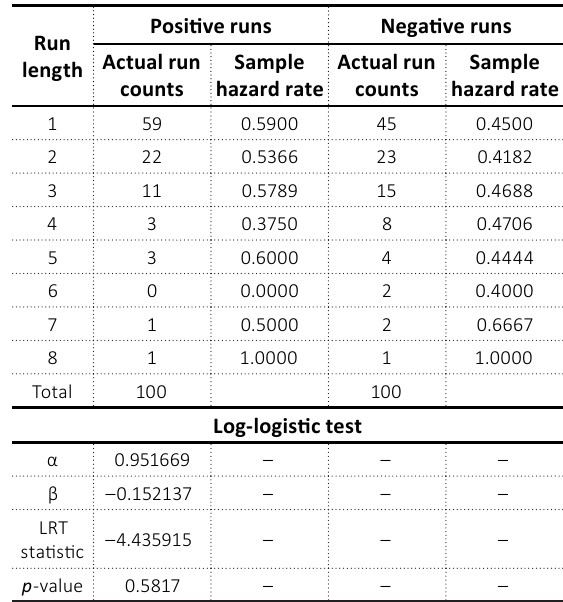
Table 2. The duration dependence